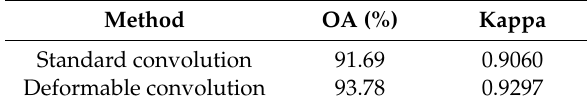
Table 7. Accuracy comparison between standard and deformable